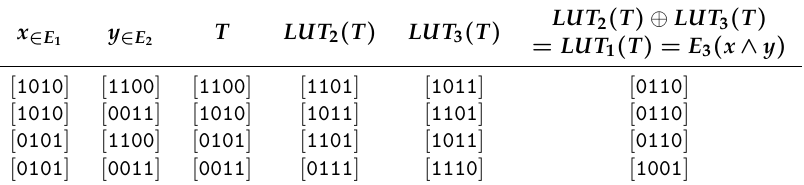
Table 2. Entries of LUT 1 , LUT 2 , and LUT 3 .